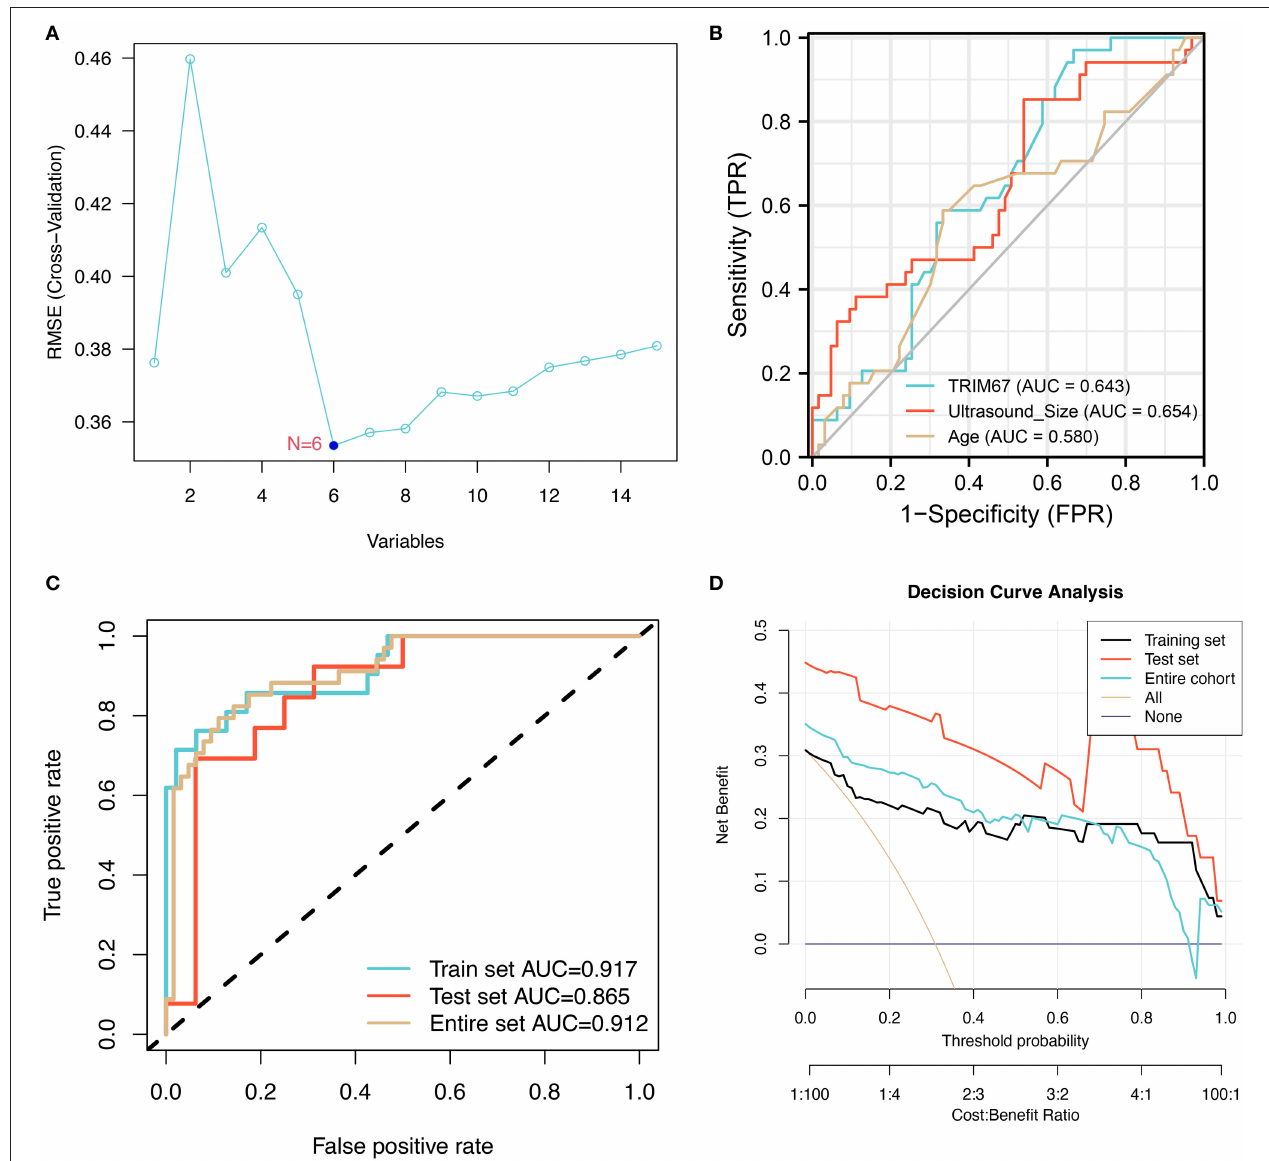
FIGURE 3 | The training process and performance evaluation of SVM-RFE models. (A) The variable screening process showed the smallest RMSE for the model when six variables were selected; (B) The ROCs show the predictive power of TRIM67 , tumor size, and age on tumor metastasis in a selection of six variables; (C) The ROC shows the predictive power of a logistic regression model combining six indicators for tumor metastasis; (D) The DCA suggested that the clinical prediction model has a good range of clinical use in the training, test, and overall